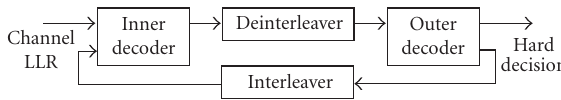
Figure 3: Iterative decoding of serially concatenated codes.